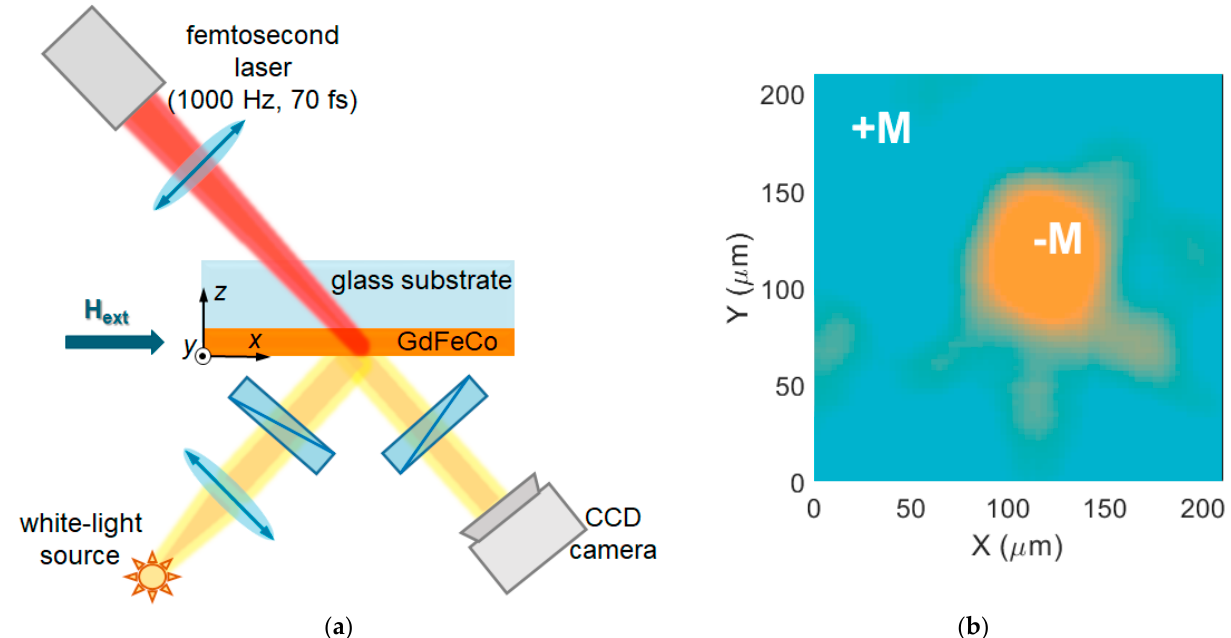
Figure 1. Irreciprocal magnetization switching of the GdFeCo film with in-plane magnetization. ( a ) Scheme of the experimental setup. ( b ) Magnetization state of the GdFeCo film (false-color image) after the exposure to a femtosecond laser pulse of similar parameters: fs-pulse induced switching for + M initial state and had no effect for – M state.